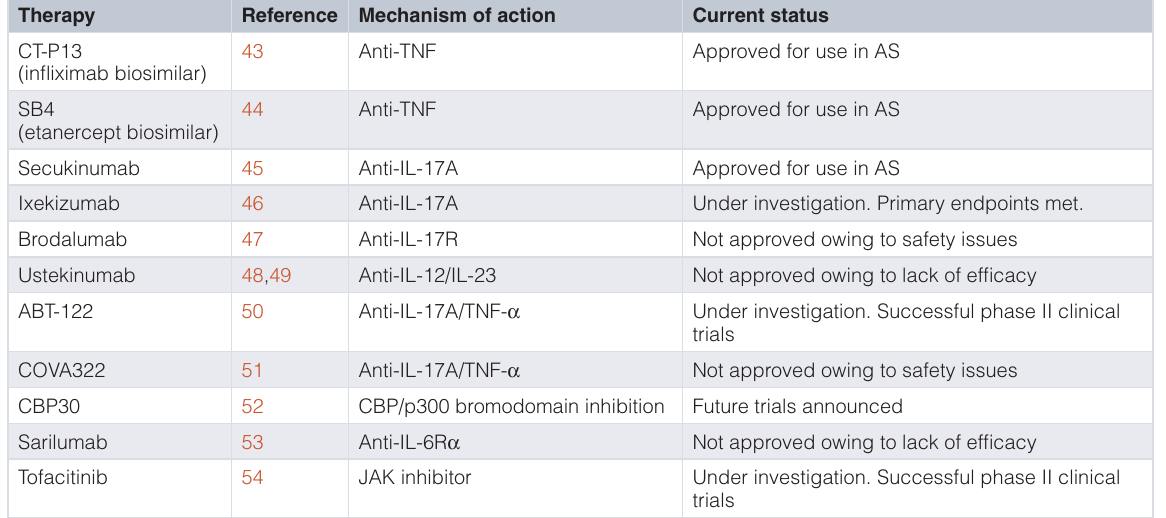
Table 1. Novel approaches for the management of ankylosing